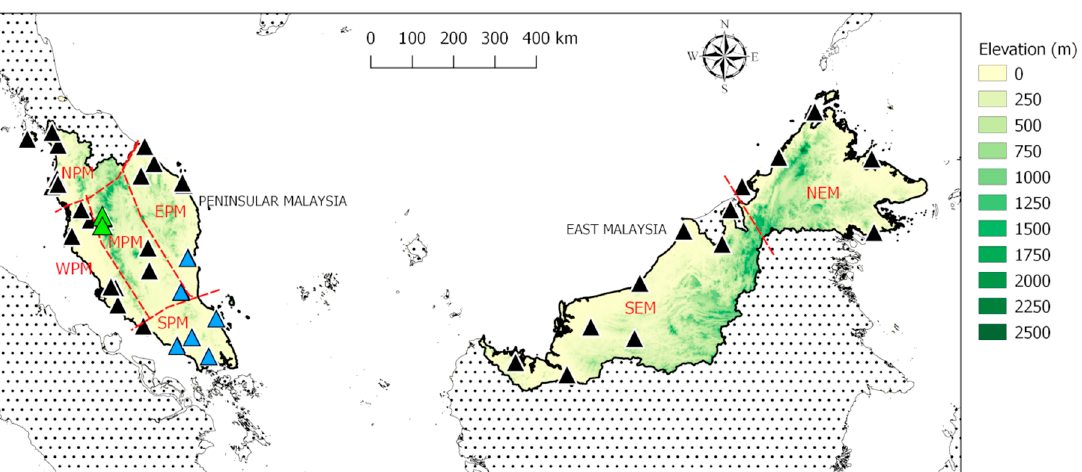
Figure 1. Rain gauge locations in Peninsular Malaysia and East Malaysia indicated by triangles. The location of station in mountainous region is denoted with green triangles, while the blue triangles indicate stations a ff ected by the 2006 / 2007 flood event.